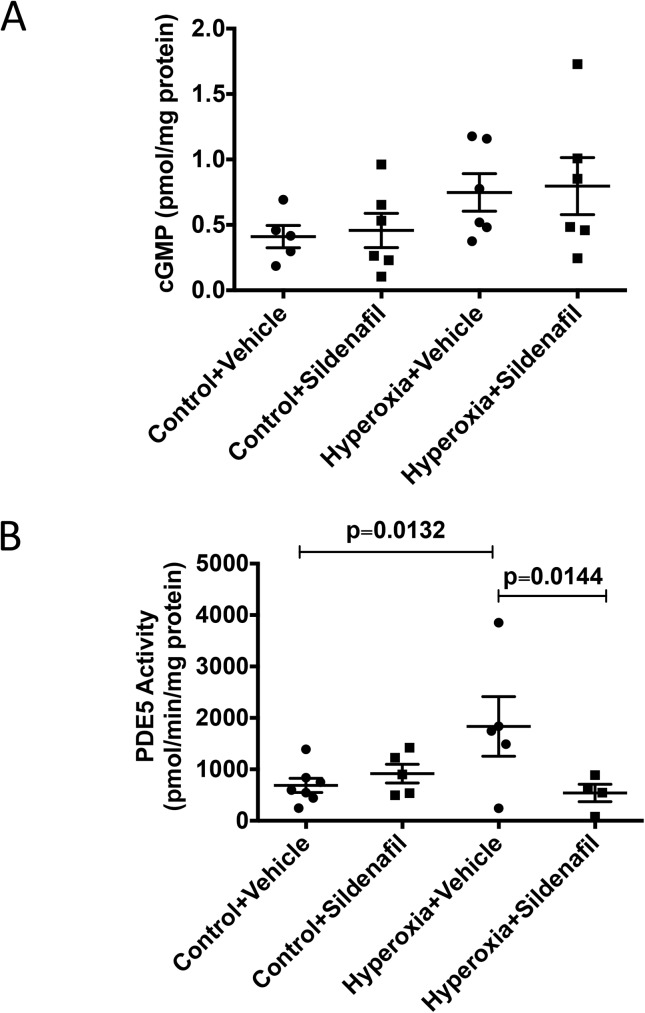
Sildenafil treatment of hyperoxia-exposed mice during recovery attenuates PDE5 activity without significant effects on cGMP levels.Mice were exposed to hyperoxia or room air for 14d, followed by recovery in room air for an additional 7d ± sildenafil or vehicle. (A) PA lysates were assayed for cGMP by enzyme-linked immunoassay, and cGMP was normalized for milligrams of total protein (n = 5–6 animals per group). (B) PDE5 specific activity was measured as the sildenafil-inhibitable fraction of total cGMP hydrolysis, normalized for total milligrams of protein (n = 4–7 animals per group). Data are expressed as dot plots with each dot representing individual animals with means and SEM represented by horizontal lines. Results were analyzed by ANOVA with post-hoc Bonferroni’s analysis.